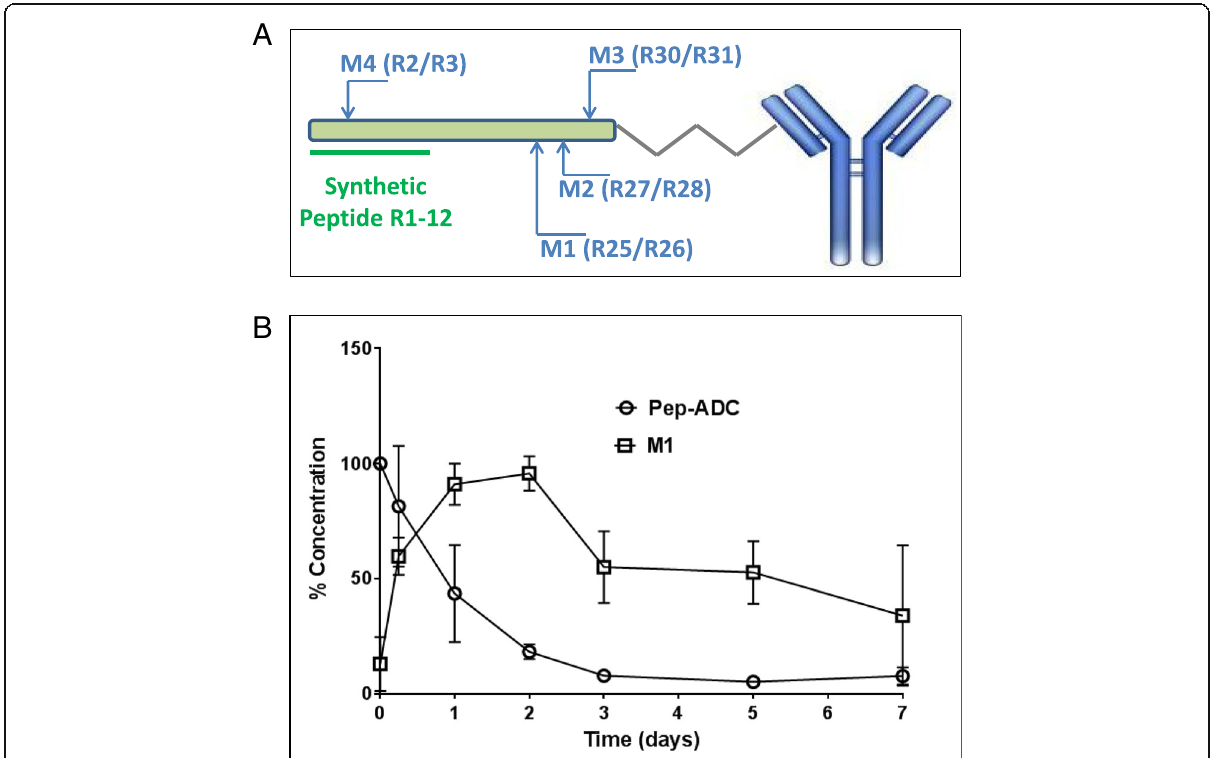
Fig. 10 Quantitative mass spectrometry based assay (LC-MRM) of intact Pep-ADC. This assay measures the concentration of the intact Pep-ADC by monitoring peptide R1 – 12 which covers the first 12 amino-acids of Pep-ADC ( a ). The relative concentration (compared to immediately after dosing) of intact Pep-ADC and main metabolite (M1) in plasma samples from C57BL/6 J normal mice IV dosed with 3 mg/kg of Pep-ADC ( b ). Data plotted are mean from three mice per time point (Exception: Day 3 has n = 2). Error bars correspond to the S.D. calculated using GraphPad Prism 7. Error bars shorter than the symbols are not plotted